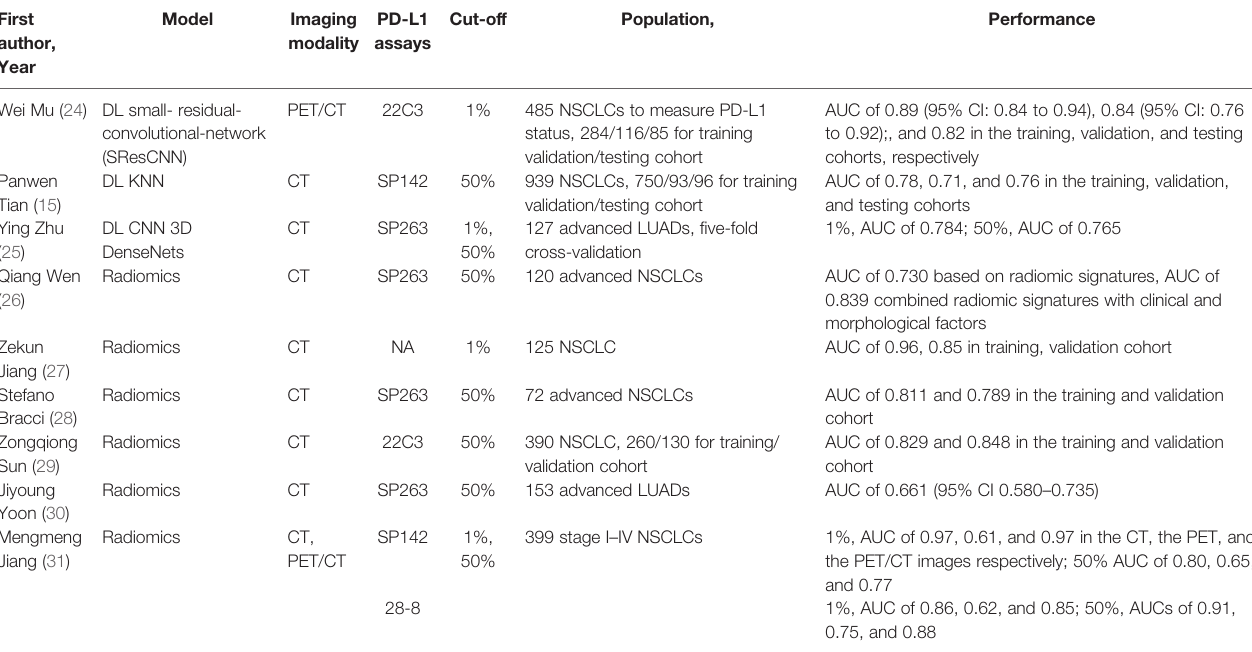
TABLE 2 | Recent studies of predicting PD-L1 status on CT images by radiomic or deep learning in lung cancer